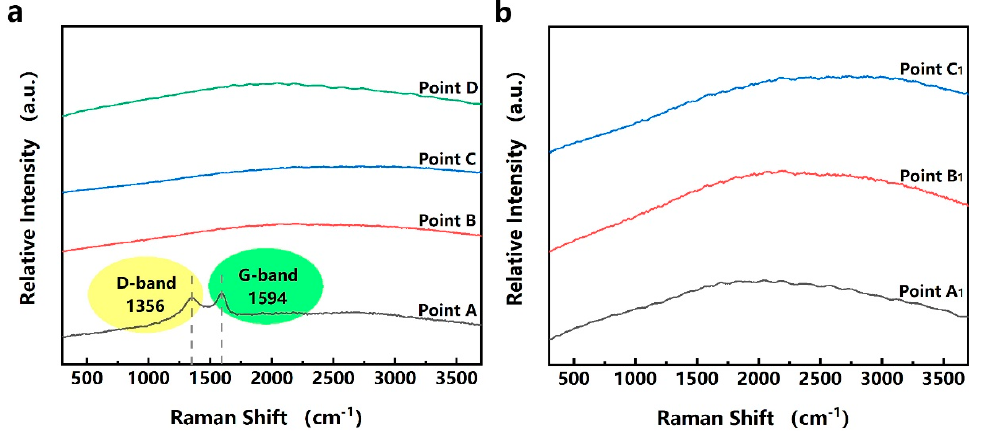
Figure 8. Raman measurements in different points in ( a ) Figure 7a and ( b ) Figure